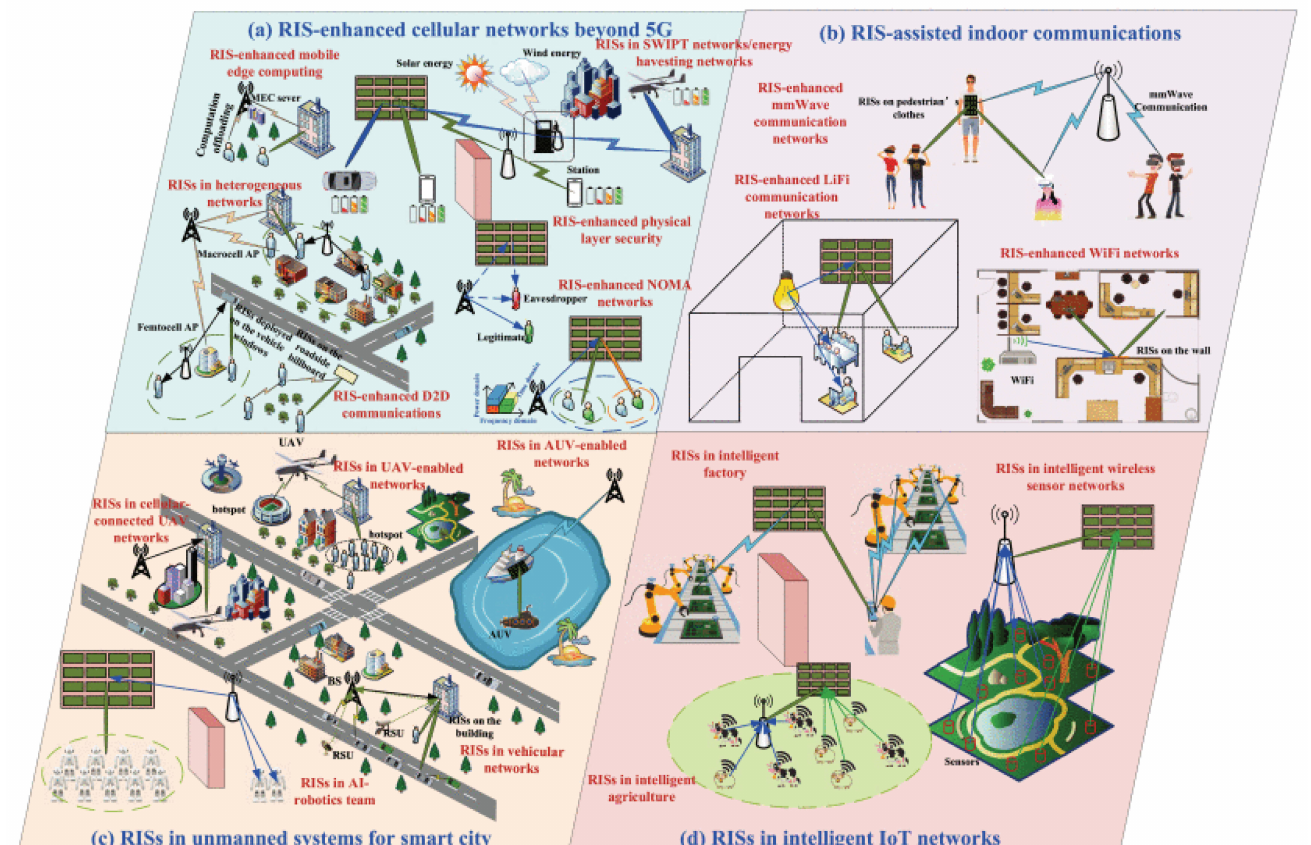
Figure 4. The RIS in wireless communication networks